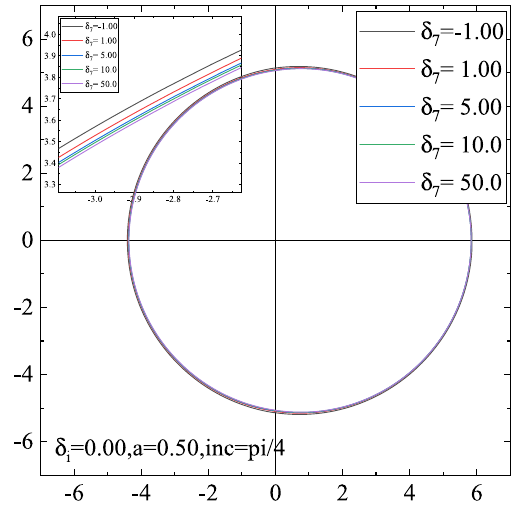
Fig. 7 The shadow of the black hole for the different values of param- eter δ